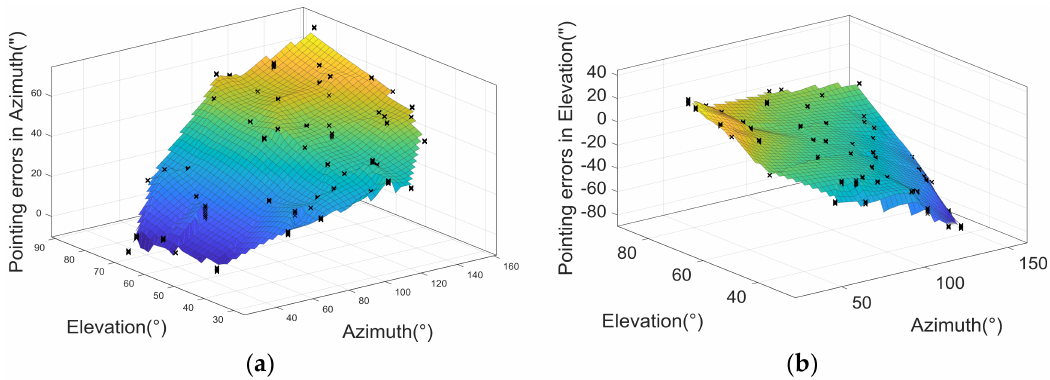
Figure 4. Original pointing errors of the alt-az telescope: ( a ) in azimuth; and ( b ) in